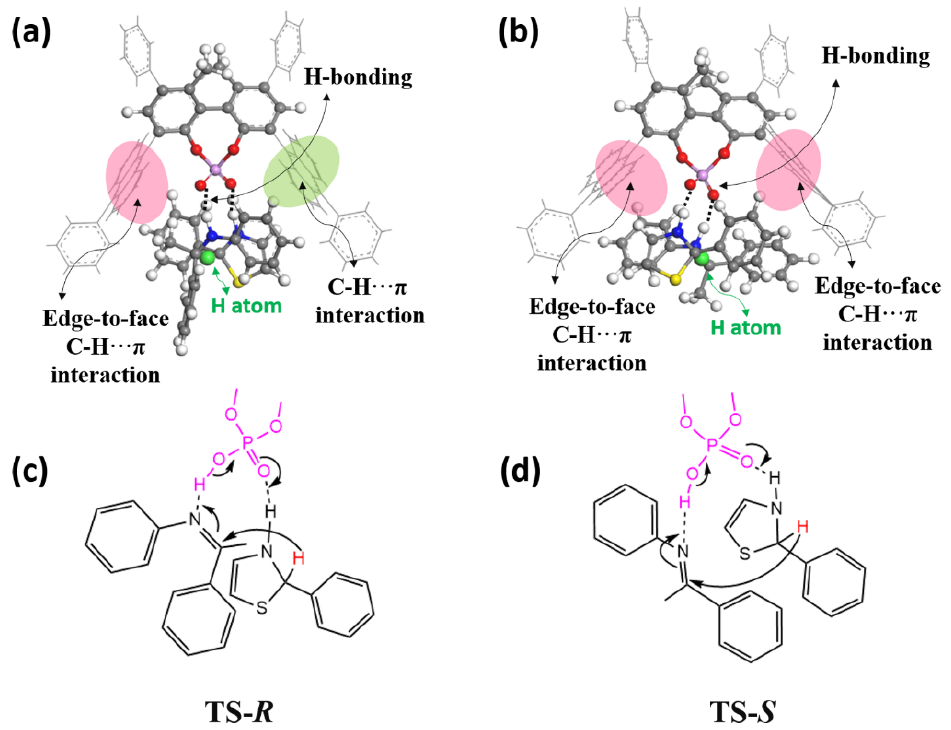
Figure 1. ( a , b ) TSs; ( c , d ) schematic representations. Color code: P, pink; O, red; N, blue; C, grey; S, yellow and transfer H, green. The pink and green cycles represent the steric effects due to edge-to-face C-H··· π and C-H··· π interactions, respectively, with a distance < 3.5 Å between the TS and cluster. Table 2. Activation barriers of TSs ( Δ G ‡ ) and their differences ( ΔΔ G ‡ ), enantioselectivities ( ee %) for the formation of ( R )-/( S )-enantiomer on In-MOFs in toluene based on DFT results. Substituent R